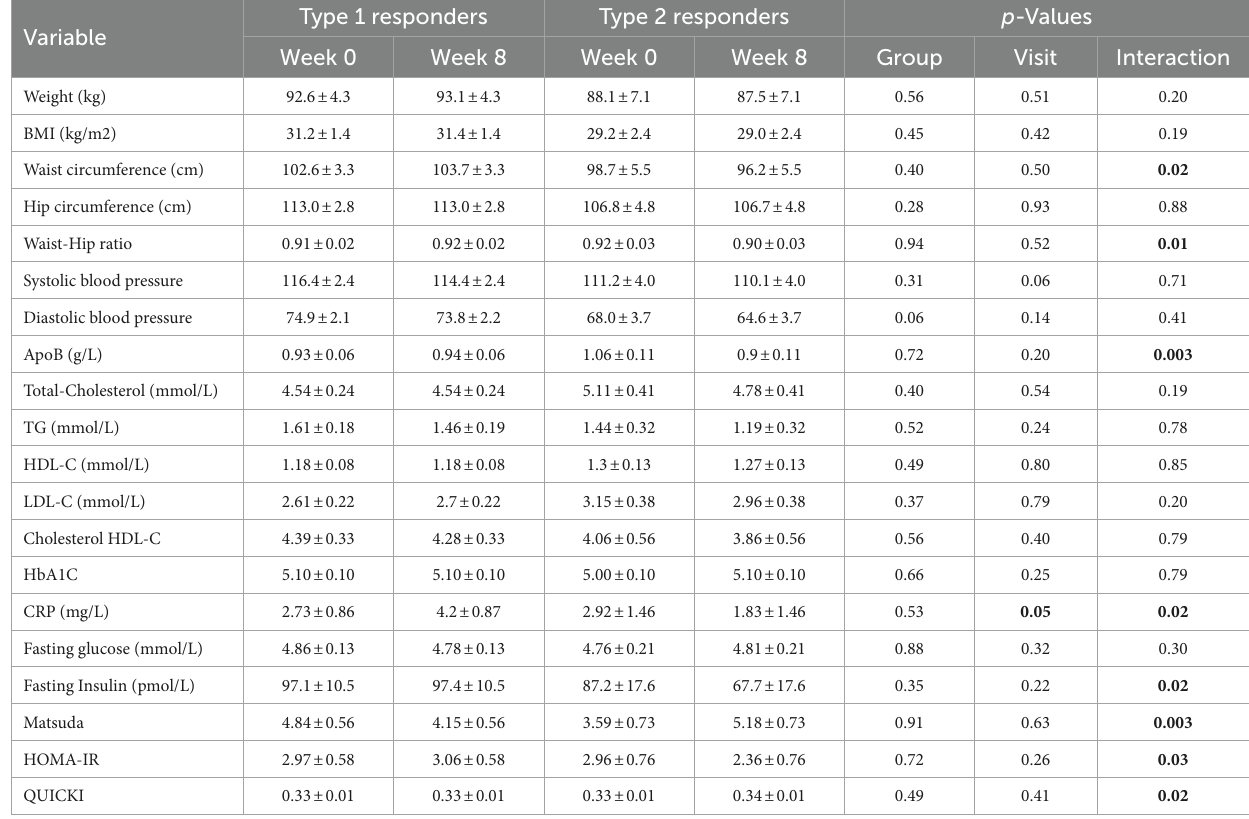
TABLE 1 Changes in anthropometric and metabolic characteristics of type 1 and type 2 responders between week 0 and week